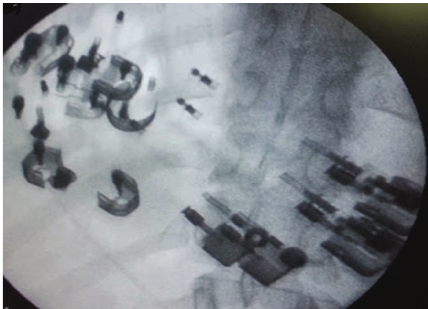
Figure 1: The plain abdominal radiograph showing lighters.